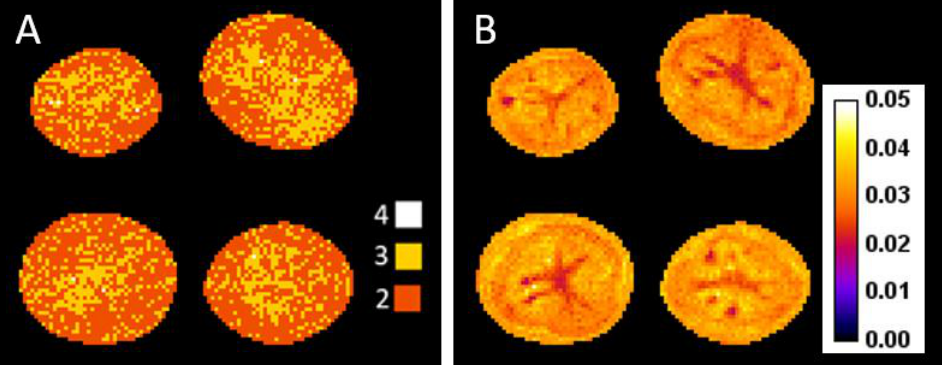
Figure 1. ( A ) Optimal number of model components (2 to 4 as indicated with different color codes) to estimate relaxation parameters for each voxel using the Bayesian Infor- to estimate relaxation parameters for each voxel using the Bayesian Information Criterion, computed mation Criterion, computed for potato images recorded at 14 WAH . ( B ) Relative error be- for potato images recorded at 14 WAH. ( B ) Relative error between the measured and the estimated tween the measured and the estimated signal at 14 WAH. signal at 14